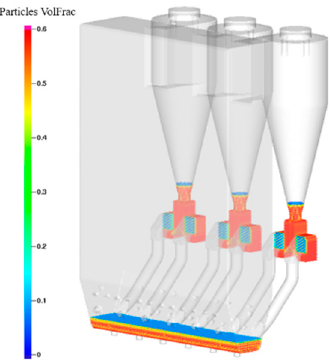
Figure 8. Initial bed material setting of the CFB boiler. Table 6. Main particle size range.